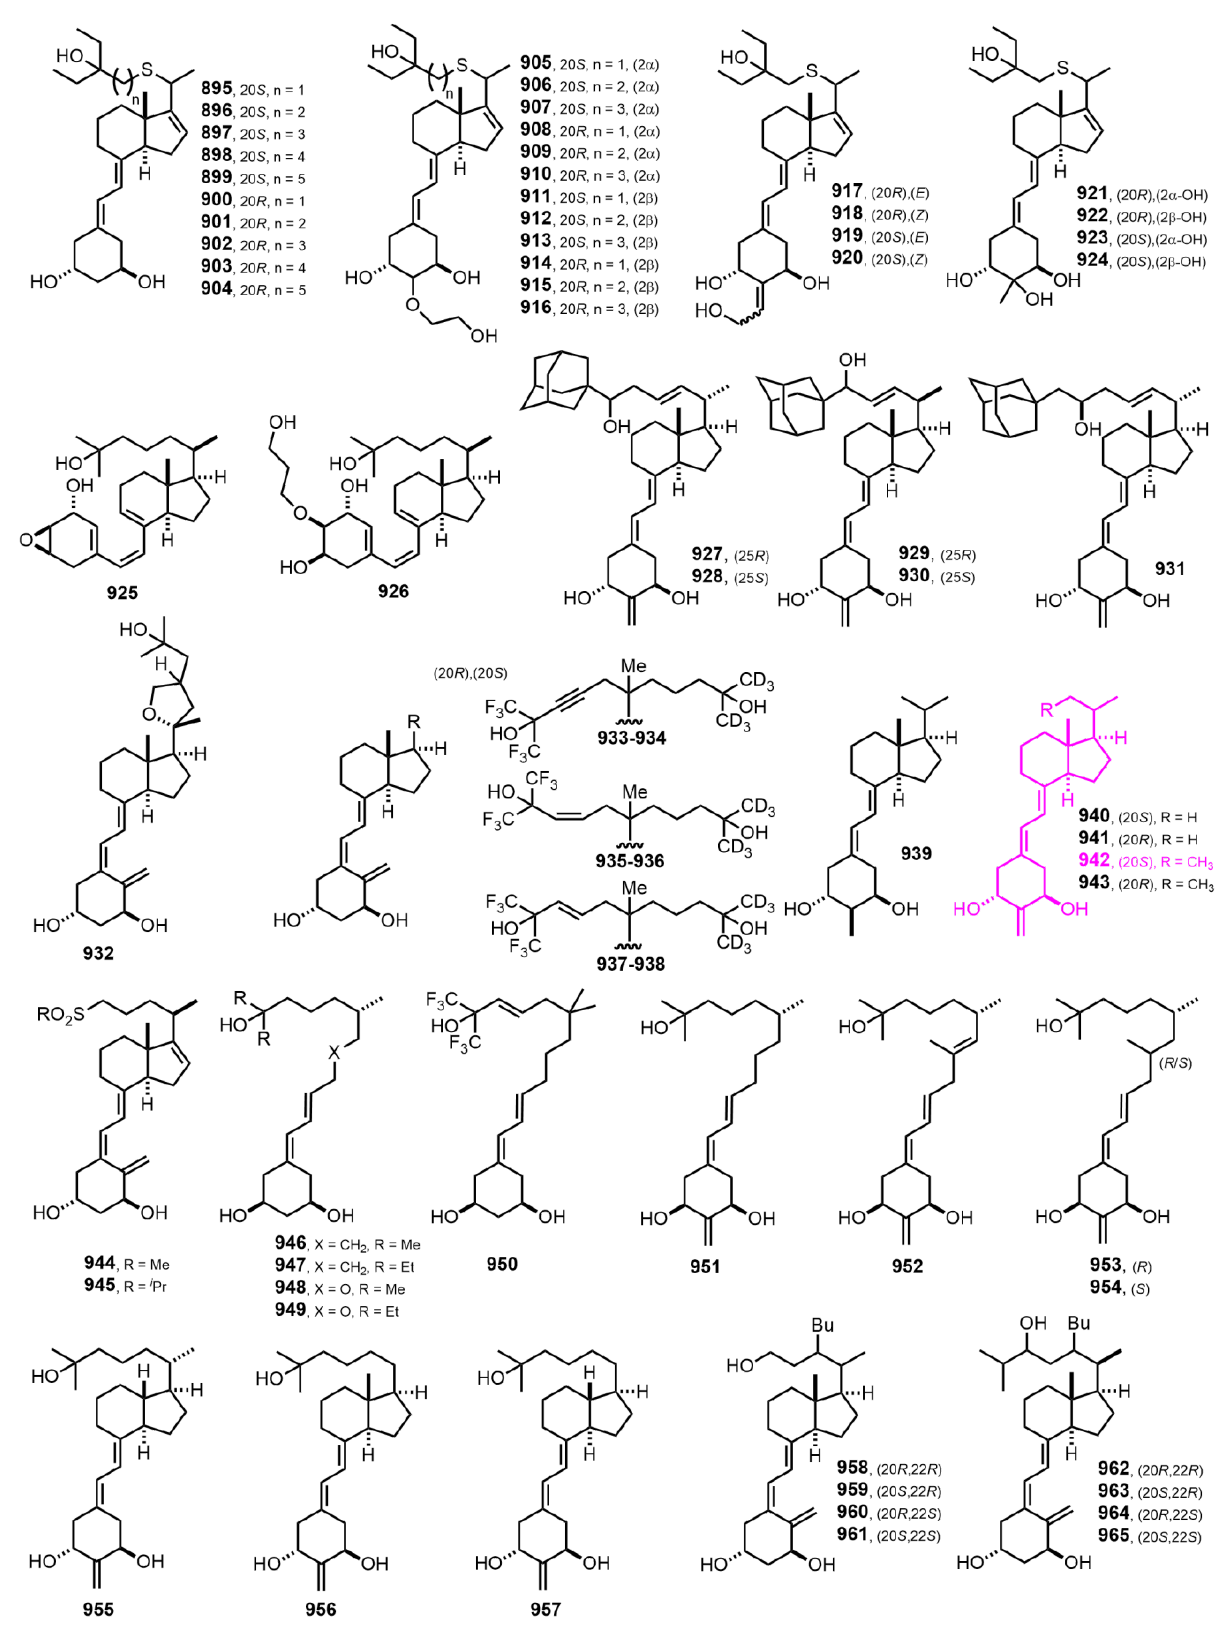
Figure 17. (2008–2009)